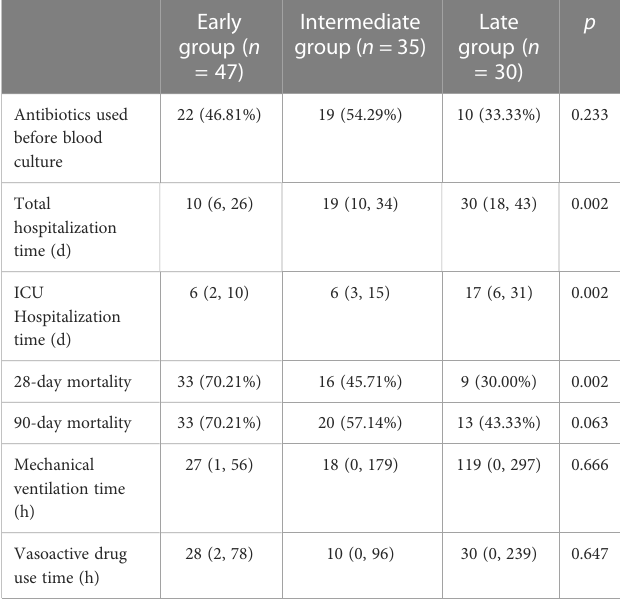
TABLE 3 Comparison of primary and secondary outcomes in early, intermediate, and late